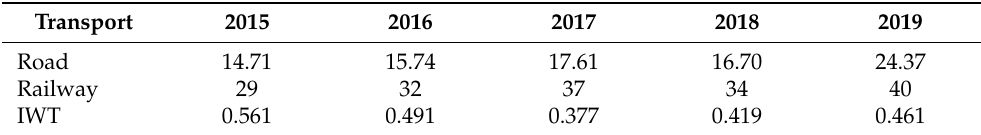
Table 2. Transportation of grain, million t.